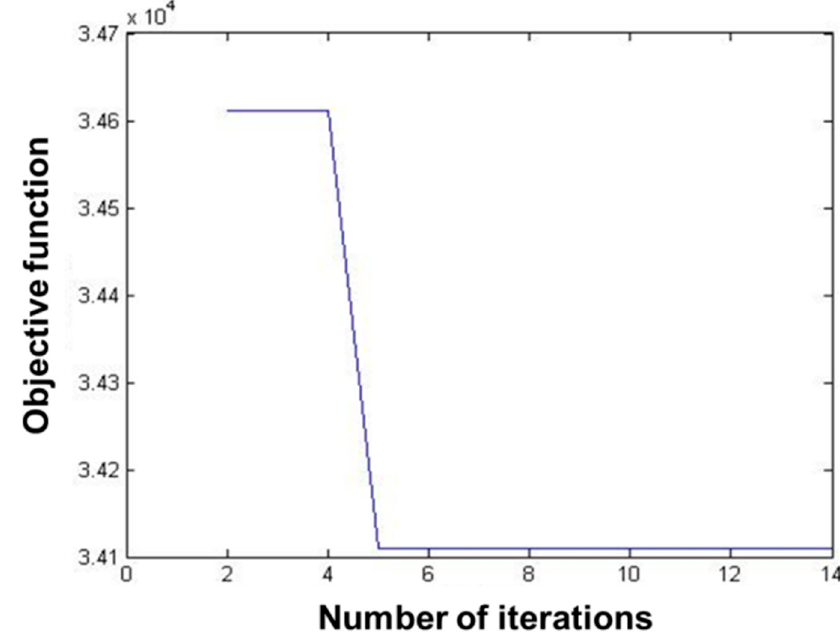
Figure 7. Convergence trajectory of particle swarm optimization.